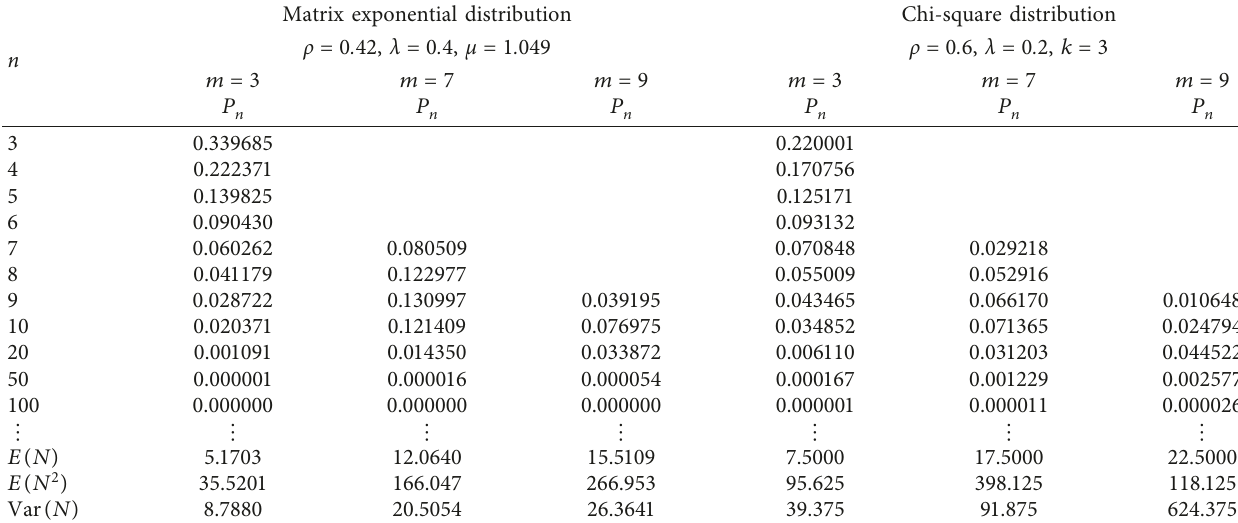
Table 3: Distribution of the number of customers served during a busy period. Matrix exponential n